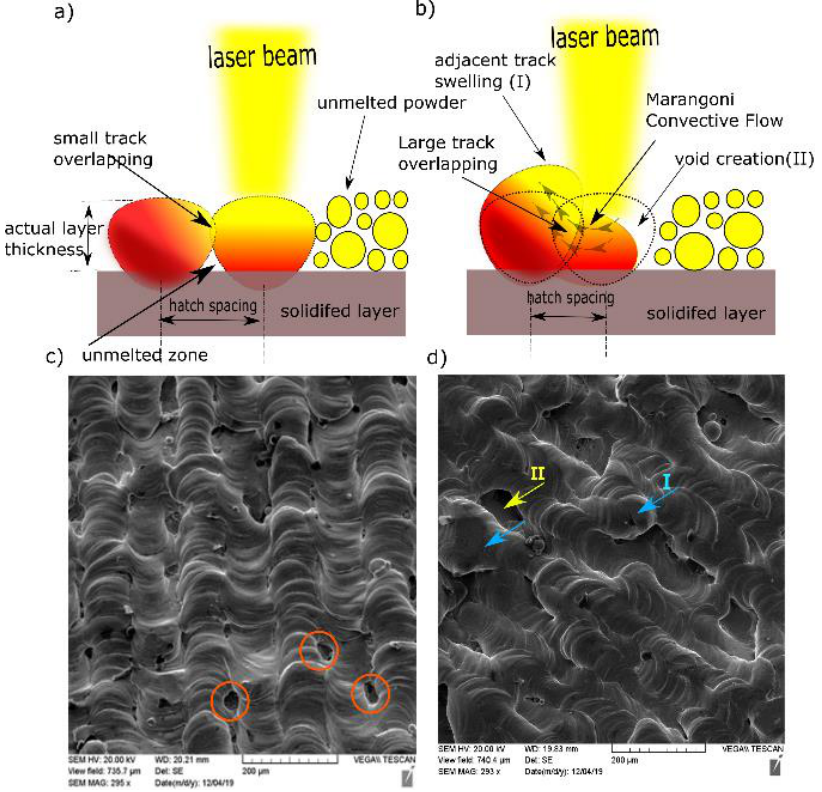
Figure 7. Schematic diagrams for ( a ) small h and ( b ) large h. SEM of top surface at P = 370 W, v = 350 mm/s for ( c ) h = 0.05 mm and ( d ) h = 0.1 mm.